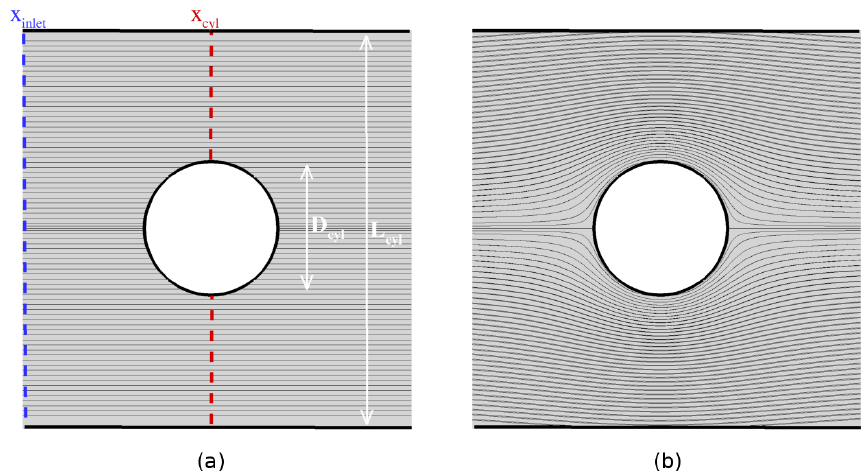
Figure 8. Potential flow around a cylinder: (a) initial state around the body of diameter D cyl = 2 R cyl ; (b) streamlines obtained after the Poisson equation resolution. The confinement is defined as L = L cyl /R cyl ).